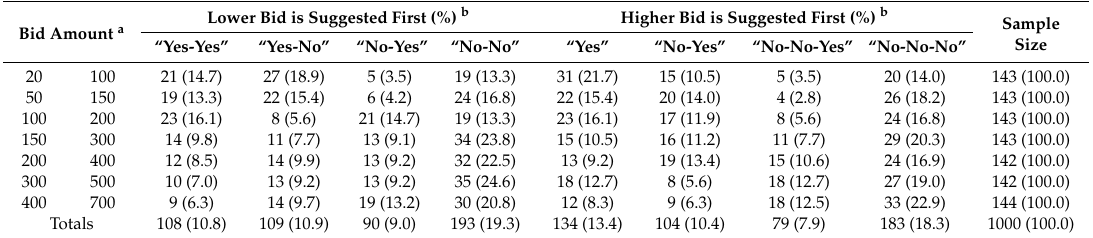
Figure 1. Method of presenting predetermined bids to interviewees and derived range of willingness to pay (WTP). Table 2. Willingness to pay responses collected from the contingent valuation survey.